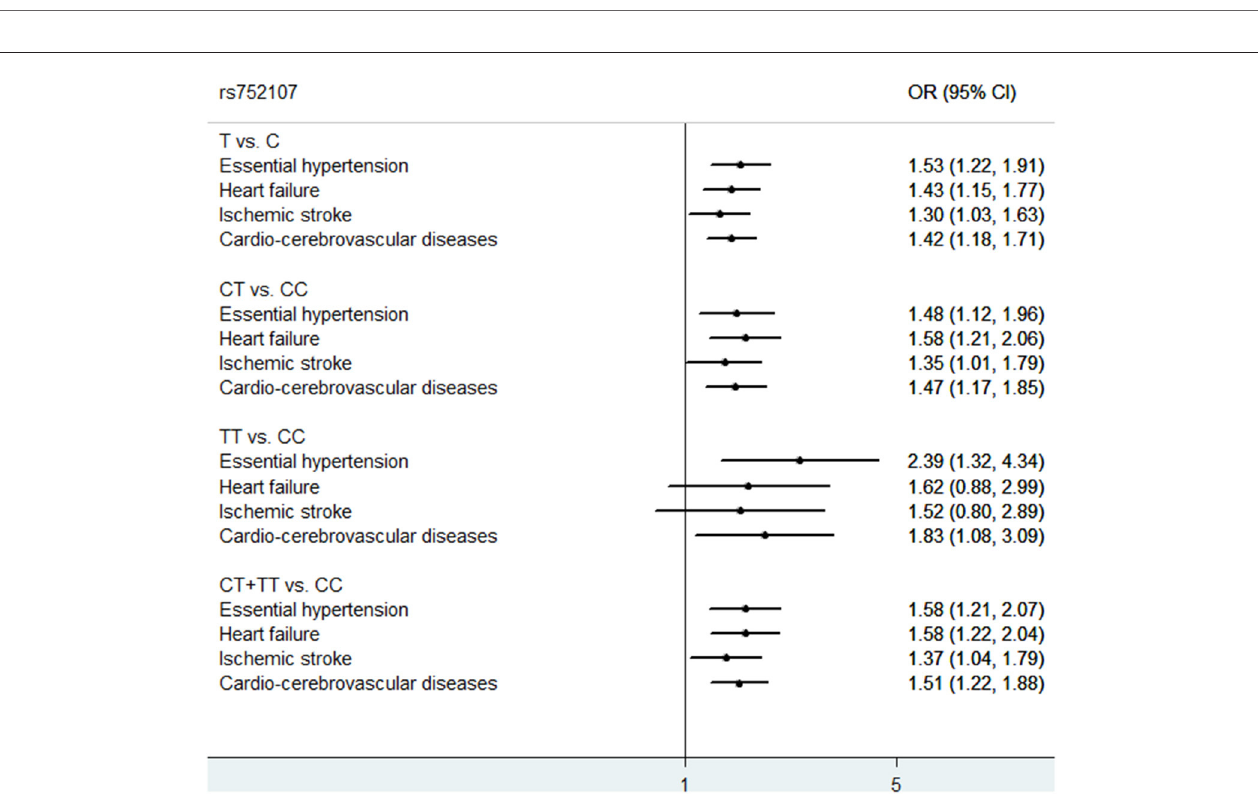
FIGURE 2 | Forest plot for genetic association of WNT3A rs752107 variant with EH, HF, and IS.